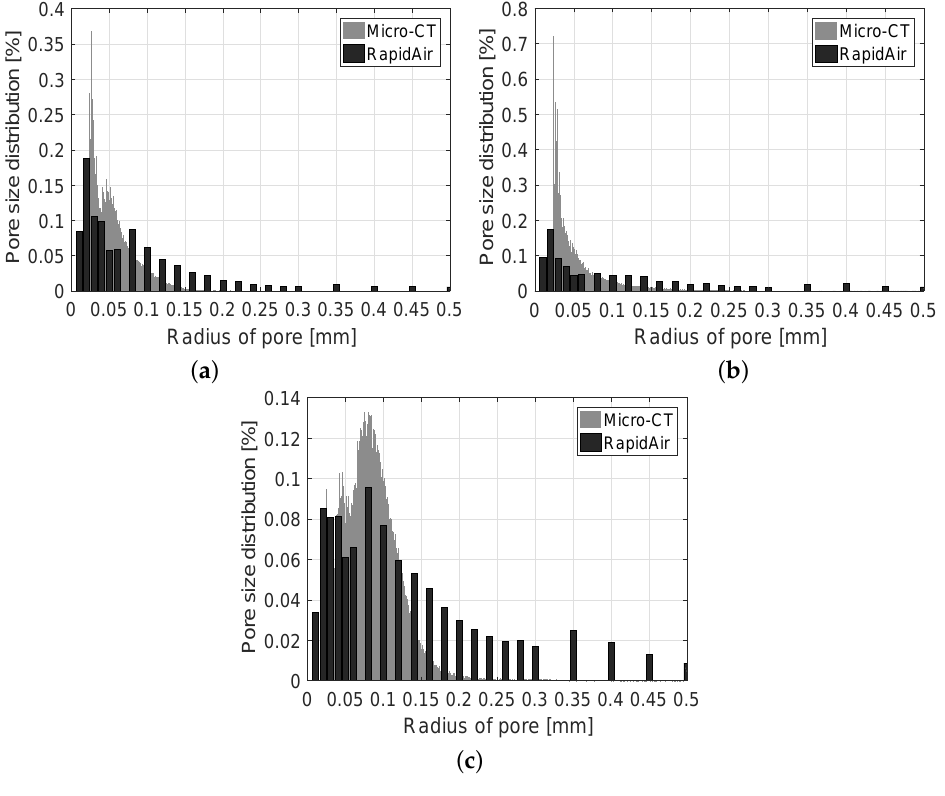
Figure 10. Pore size distributions of the specimens measured from µ -CT and RapidAir: ( a ) NS specimen; ( b ) CG specimen; ( c ) EG